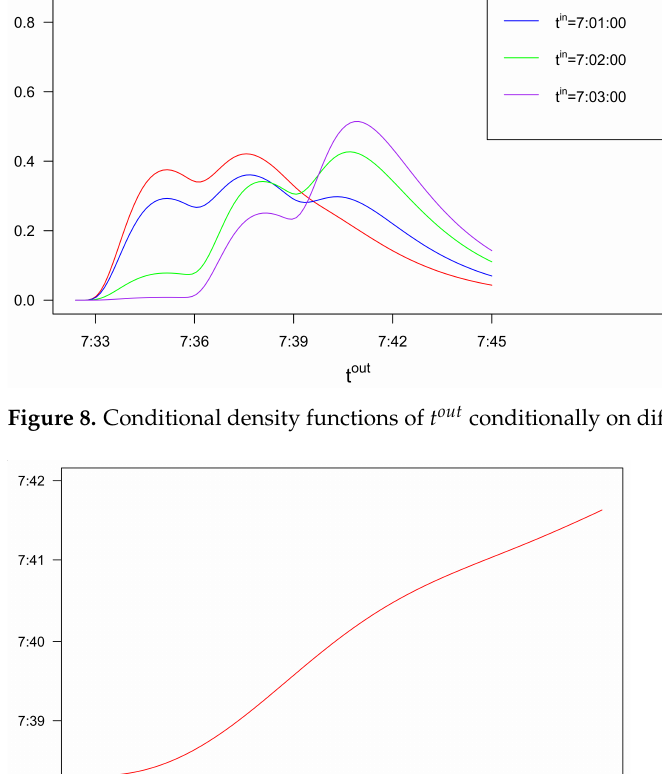
Figure 10. Curves of P ( T transfer = T ∗